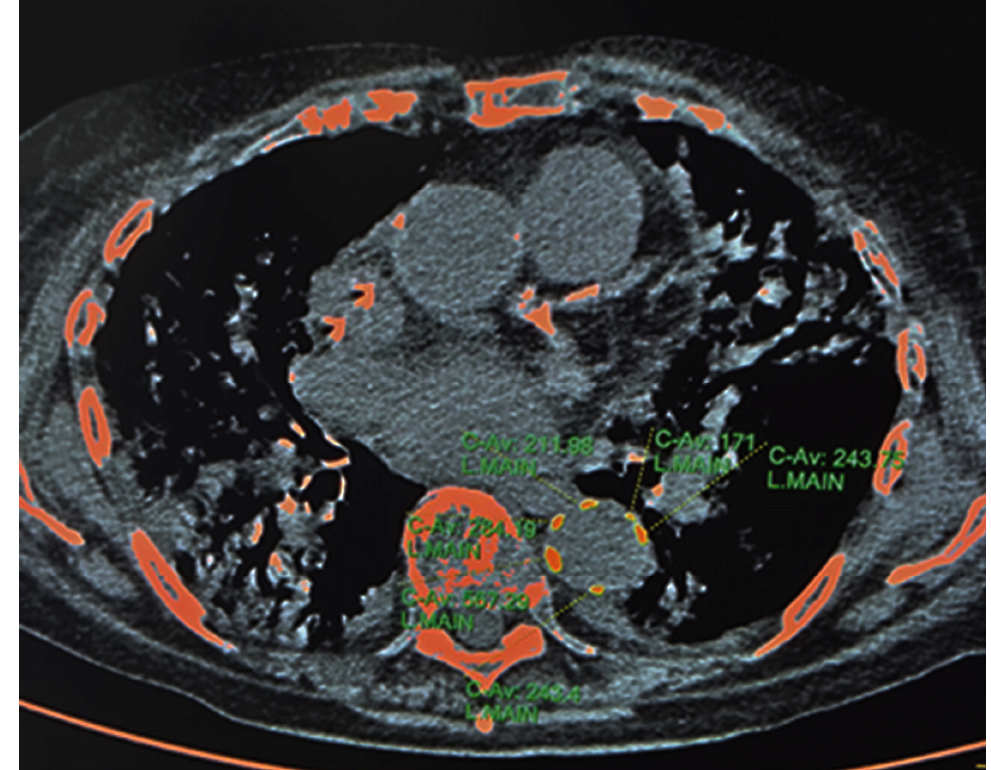
Figure 1. Calcifications of descending thoracic aorta—Agatston Score. Credits: AUSL Romagna.